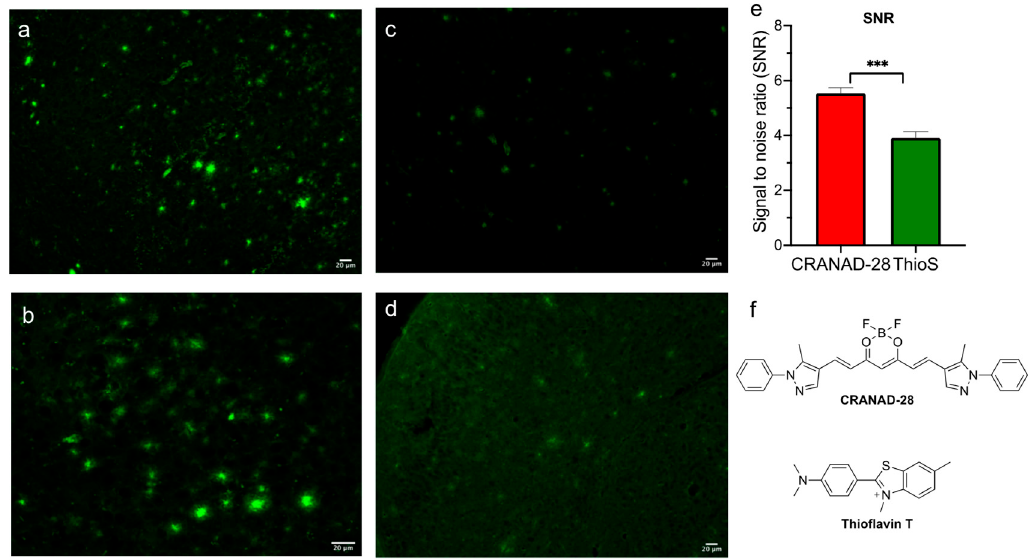
Figure 1. Representative images from APP/PS1 brain slice staining for brightness assay and SNR analysis. ( a ) A brain section stained with 20 uM CRANAD-28 (with a 20× object lens); ( b ) a brain section stained with 20 uM CRANAD-28 (with a 10× object lens); ( c ) a brain section stained with 20 uM Thioflavin S (with a 20× object lens); ( d ) a brain section stained with 1mg/mL Thioflavin S (with a 10× object lens); All images taken with fluorescence microscope and SPOT Advanced Imaging Software. Blue excitation filter with gain 4 and exposure time 335 ms. Scale bar: 20 μ m; ( e ) quantitative SNR analysis results of staining with CRANAD-28 and Thioflavin S; ( f ) chemical structures of CRANAD-28 and Thioflavin T.